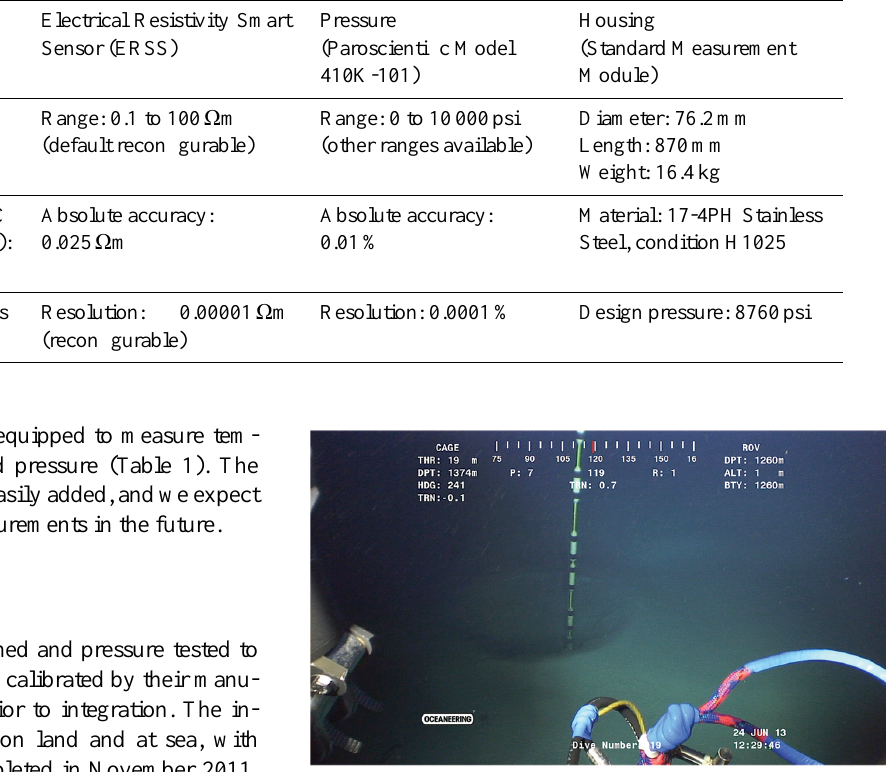
Figure 3. SCIMPI installation in the seafloor at Site U1416 as im- aged with an ROV on 24 June 2013, Oceans Network Canada dive No. 19 to the Clayoquot Slope region (Image © : Ocean Networks